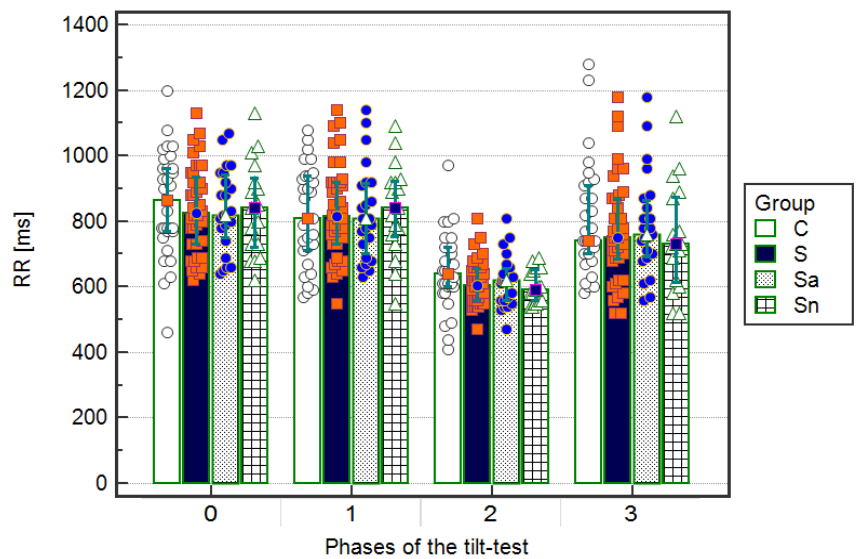
Figure 2. Inter-time comparison of RR intervals in electrocardiograms (ECGs) on admission to the hospital (Phase 0), during the resting supine phase (Phase 1), the upright phase (Phase 2), and the returning to supine phase (Phase 3) in the groups: C—control, S—syncopal Sa—syncopal with